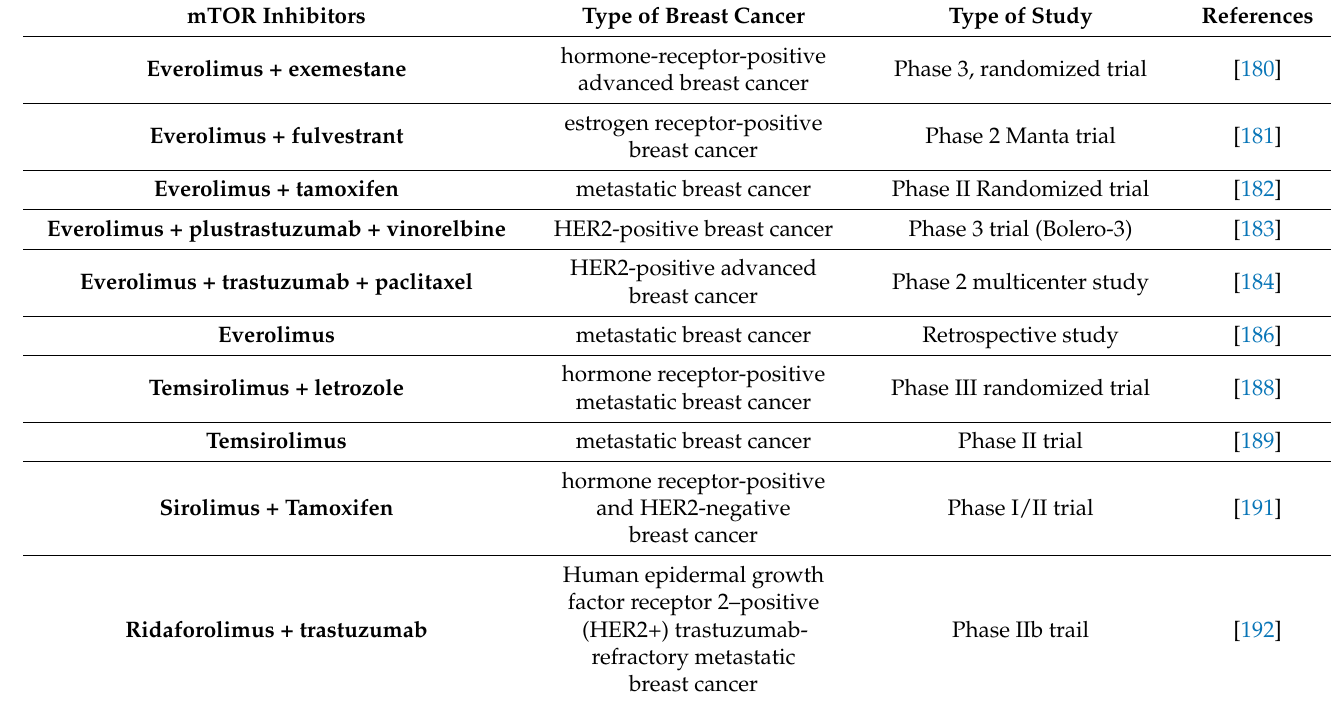
Table 1. The main mTOR inhibitors, used in various clinical trials in patients with different breast cancer